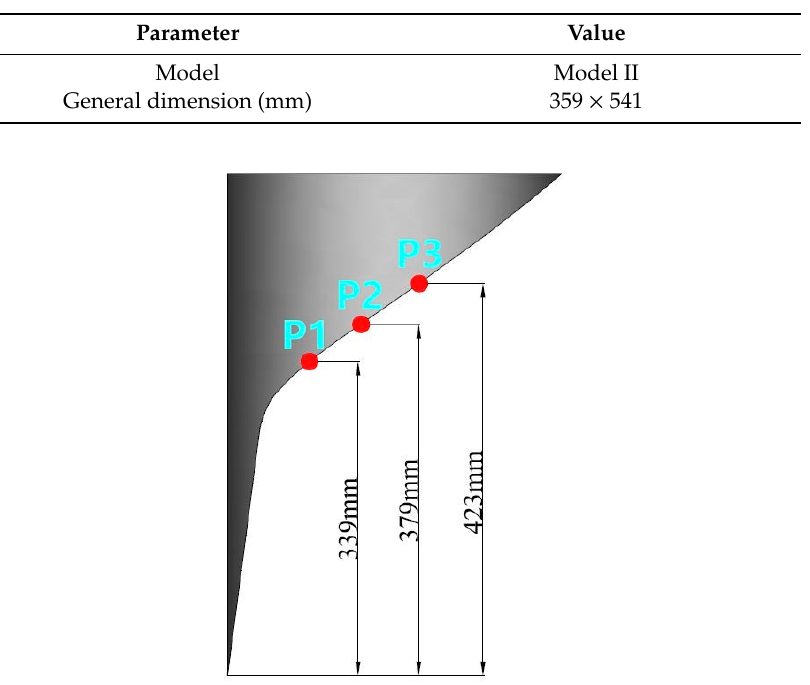
Table 2. Parameters of the test model.